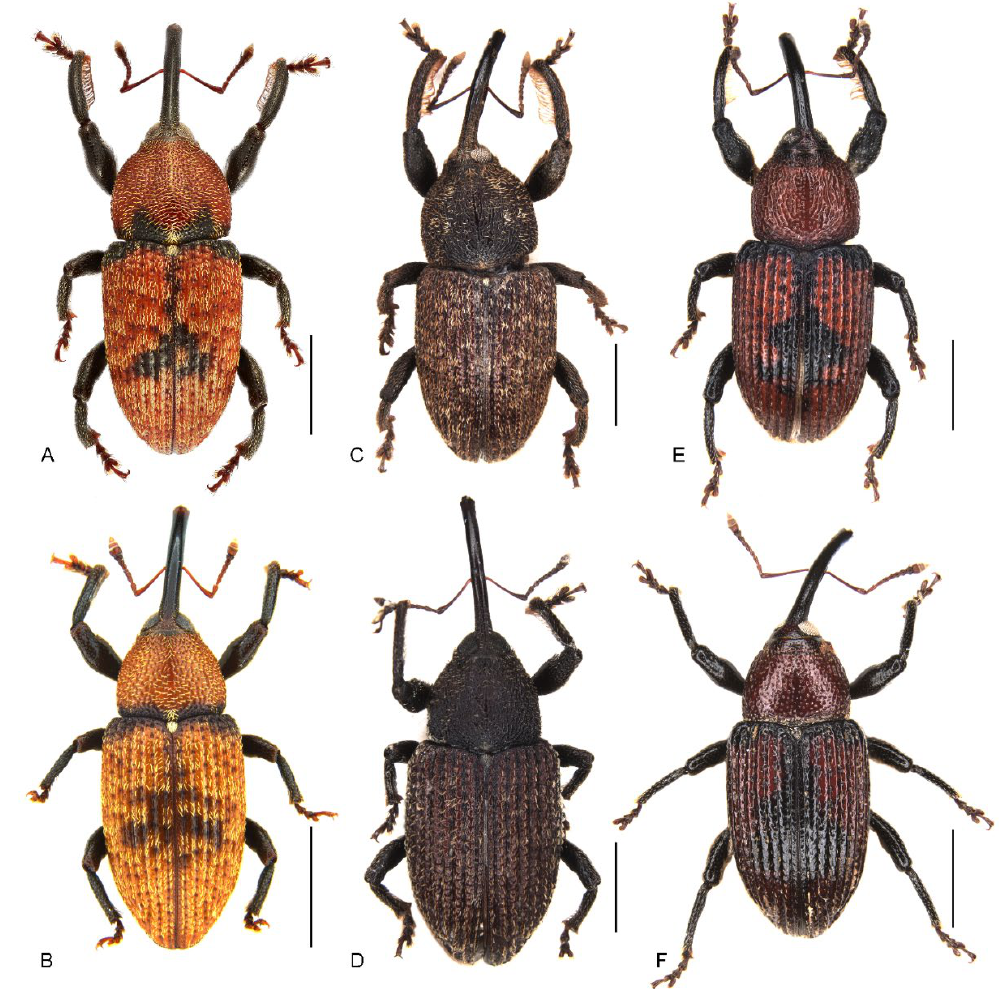
Figure 1. Habitus of Miltotranes adults, dorsal view: ( A ) M. prosternalis , male; ( B ) ditto, female; ( C ) M. subopacus , male; ( D ) ditto, female; ( E ) M. wilsoni sp. n., holotype; ( F ) ditto, female, paratype. Scale bars: 2.0 mm.